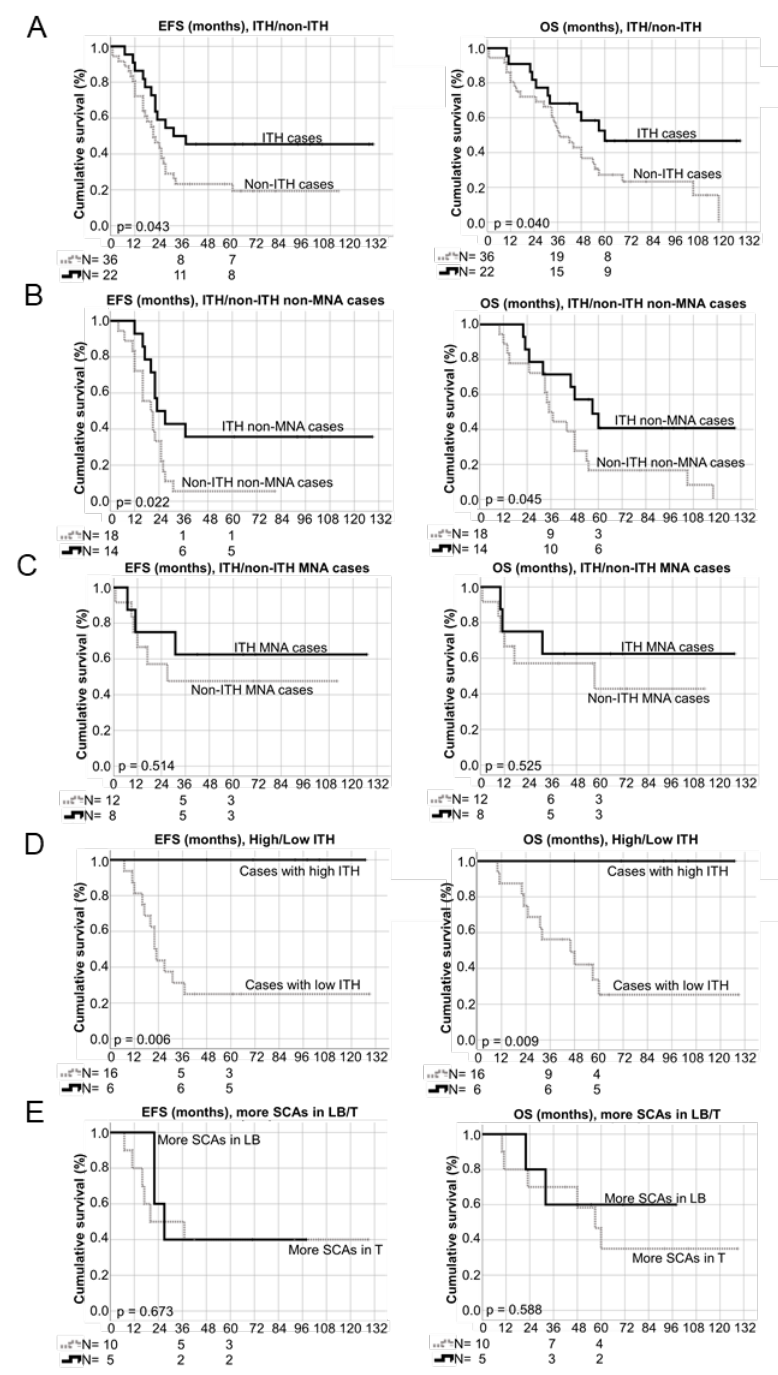
Figure 5 . Kaplan–Meier graphs showing event free and overall survivals (left side, EFS and right side, OS) depending on different variables: ( A ) intra-tumour heterogeneity (ITH) detected or not detected (non-ITH) in all the studied cases; ( B ) ITH detected or not detected (non-ITH) in MYCN non-amplified (non-MNA) cases; ( C ) ITH detected or not detected (non-ITH) in MYCN amplified (MNA) cases; ( D ) high ITH (tumors with 50% or more different genomic events between the analysed samples) versus low ITH (tumours with ITH but with less than 50% different genomic events between the analysed samples); ( E ) higher number of segmental chromosomal aberrations (SCAs) observed in liquid biopsy (LB) versus higher number in solid tumour (T) samples. N: number of cases. 3-year and 5-year number of survivors, as well as p -values are